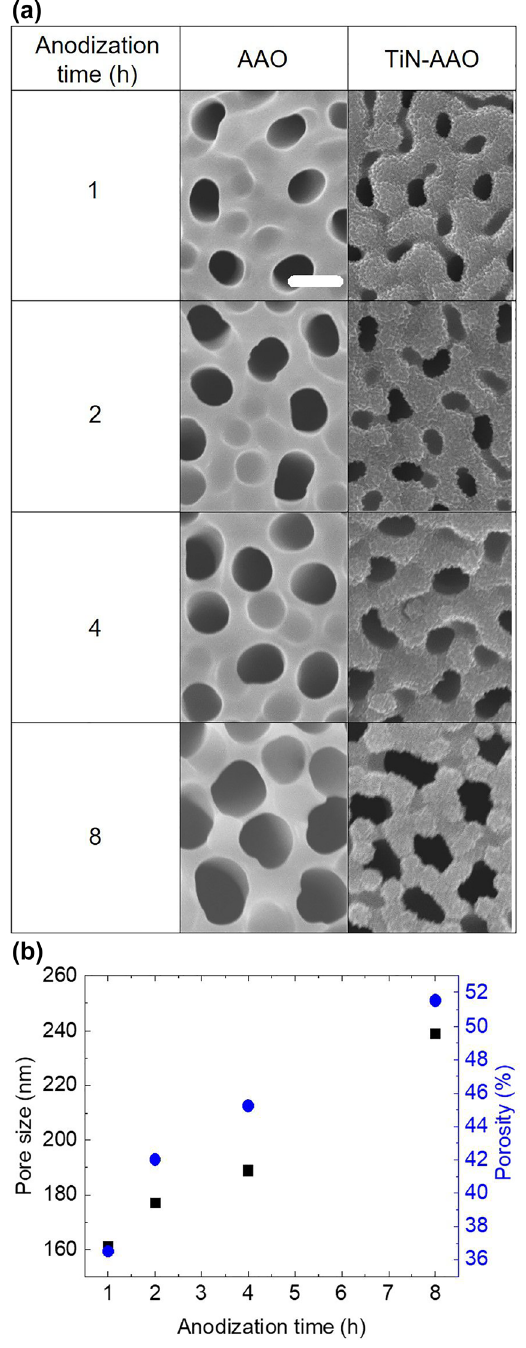
Figure 1: Morphologies of AAO and TiN-AAO after pore-widening for 1 h.